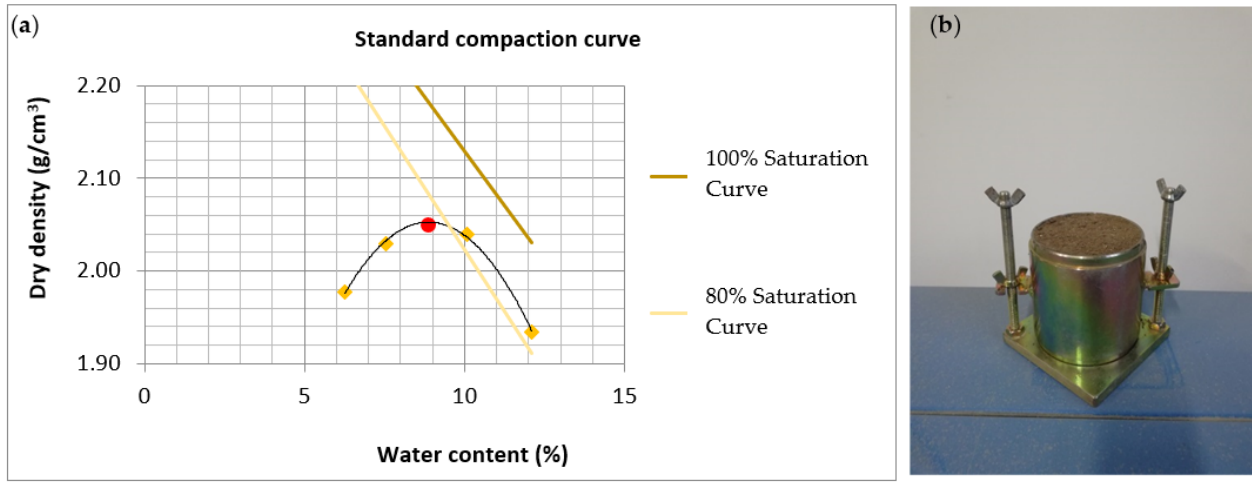
Figure 5. Proctor test results of the corrected soil S3: ( a ) results with the saturation curves; ( b ) standard Proctor test equip- ment—mold.